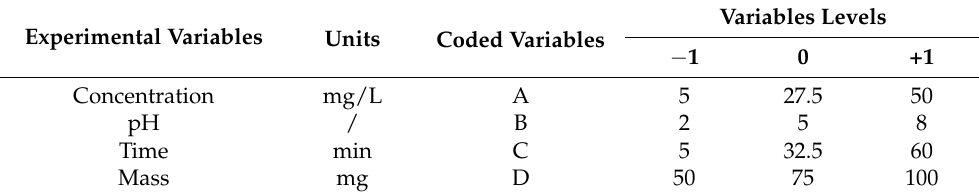
Table 1. Coded and experimental variables. Experimental